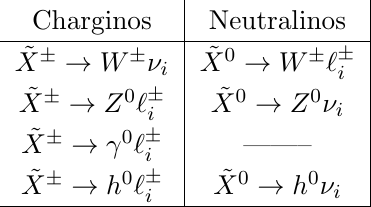
Table 3. Chargino and Neutralino RPV decay channels, expressed in terms of 4-component